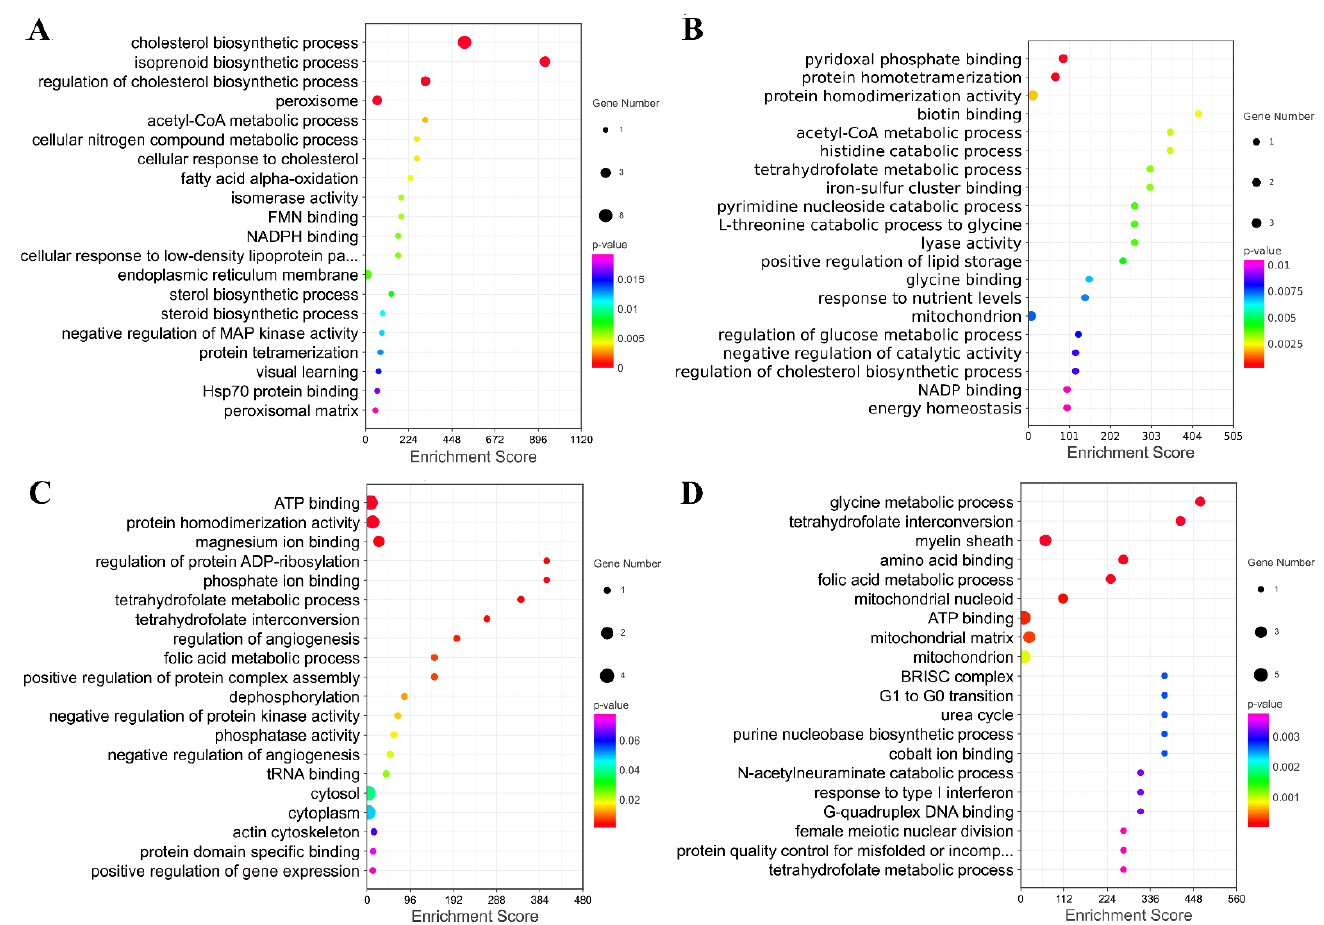
Figure 9. The GO Enrichment Analysis of Four Modules Extracted from PPI. ( A – D ) Top 20 GO terms enriched by genes in these four modules.